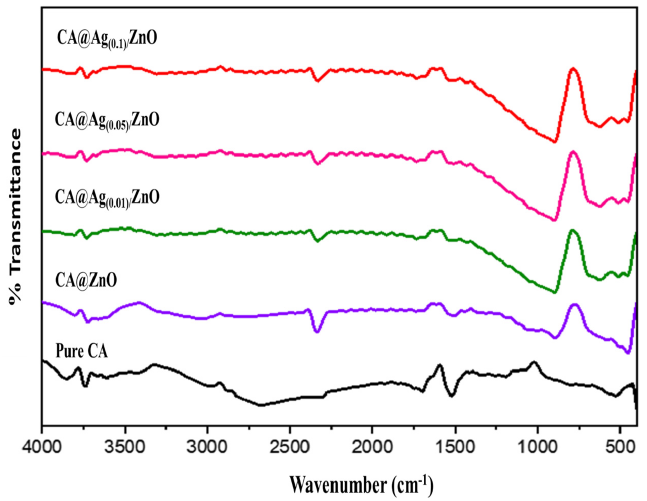
Figure 4. FTIR of pristine CA, CA/ZnO, and CA@Ag (0.01, 0.05, 0.1)/ ZnO hybrid